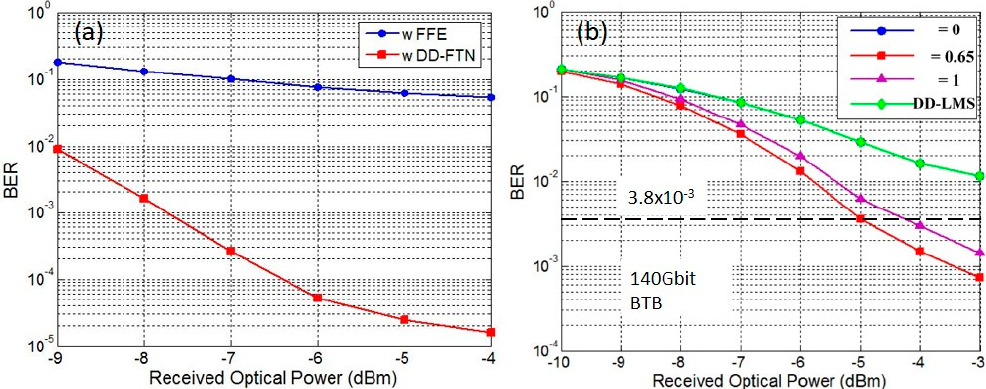
Figure 10. ( a ) The bit error rate (BER) performance versus received optical power for 112 Gbps PAM4 signal after 2 km SSMF transmission (reprinted from [33] with permission from authors). ( b ) The BER